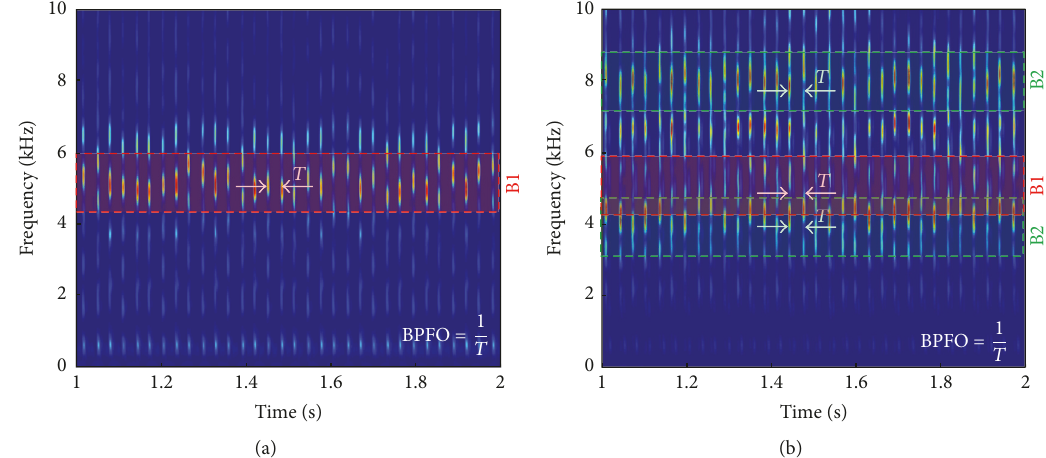
Figure 17: Time-frequency representations of the captured signals from S3 for (a) case study 1: single faulty bearing and (b) case study 3: multiple faulty bearings.